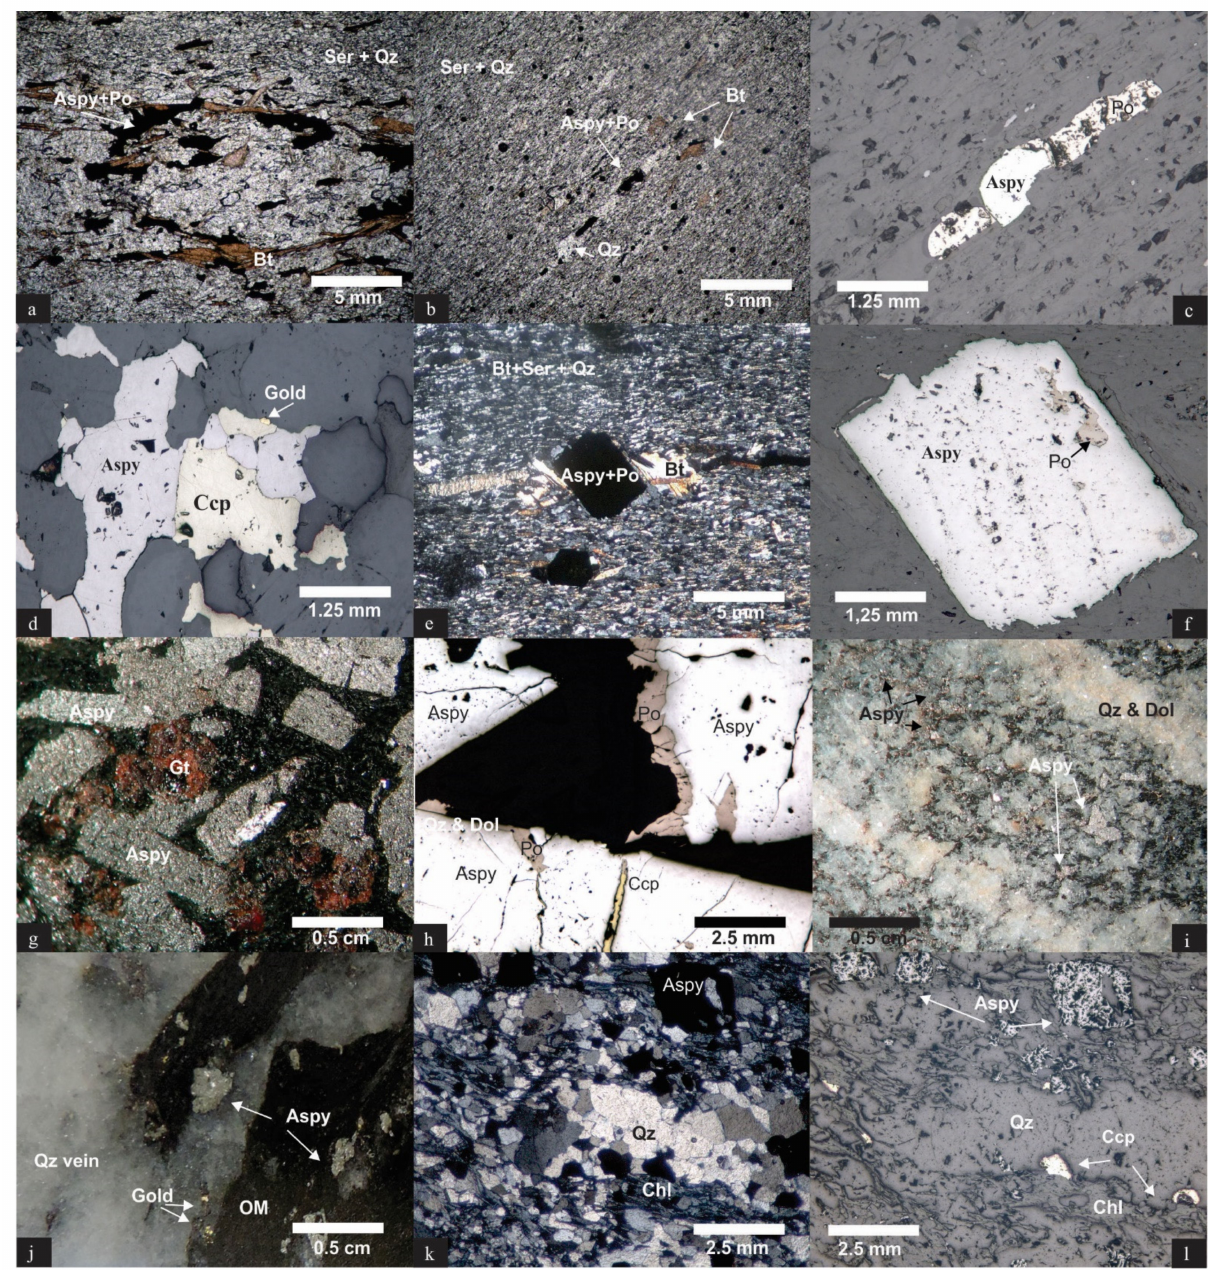
Figure 11. Photomicrographs of different ore styles from the Crix á s gold deposit, such as disseminated sulfide (Aspy, Ccp, Po) associated to pervasive silicification at the Pequiz ã o orebody ( a – f ), massive sulfide (Aspy, Po, Ccp) lenses ( g , h ) and disseminated sulfide ( i ) at the Mina III Upper Zone orebody and free gold flakes in quartz-vein ( j ) and disseminated sulfide ( k , l ) at the Ing á orebody. Photomicrographs taken under cross-polarized light ( a , b , e , k ), natural light ( g , i , j ) and reflected plane-polarized light ( c , d , f , h , l